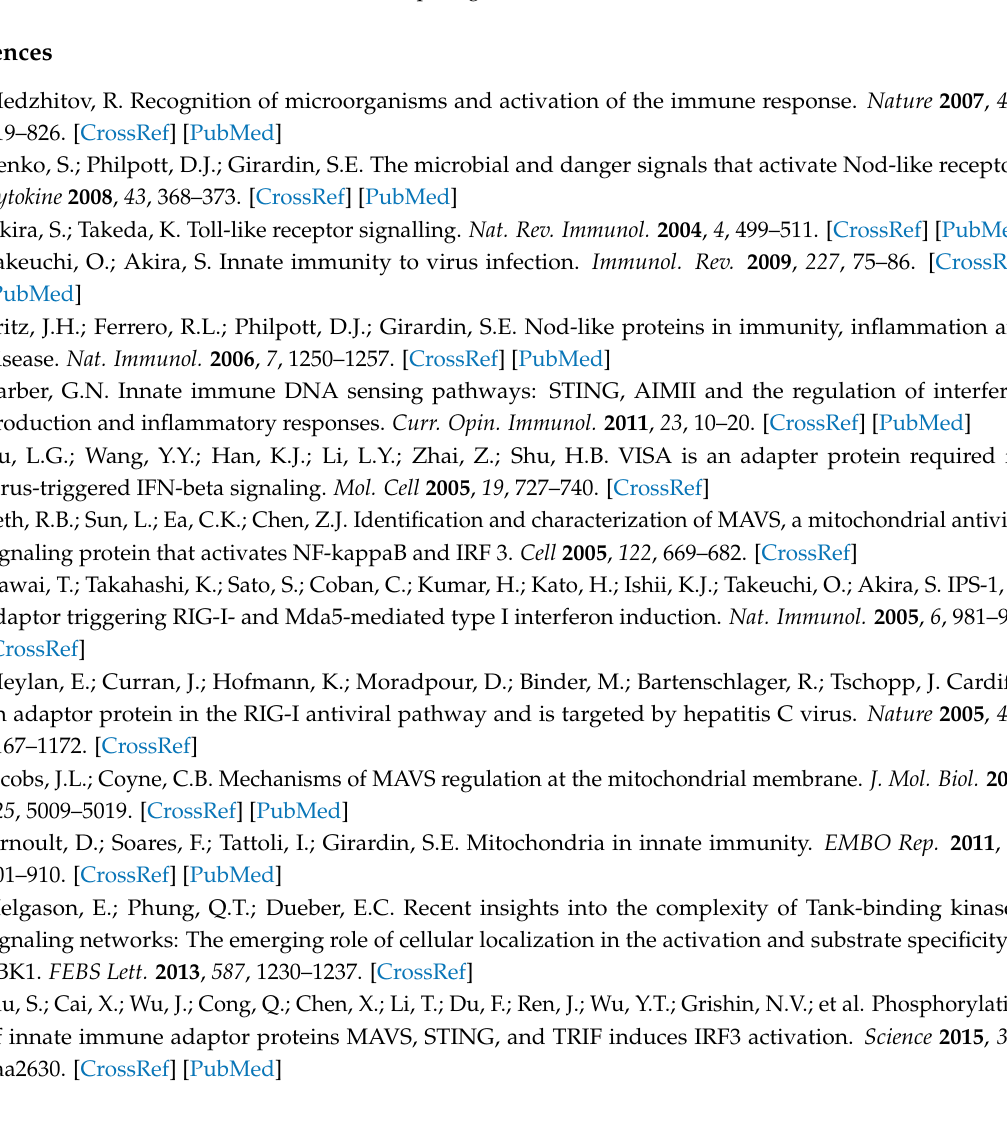
Figure S1: S1 (A) Overexpression of THOC7 promoted degradation of TBK1 in MCF7 cells. MCF7 cells were seeded into 6-well plates and transfected with Flag-THOC7 (3 µ g). After transfection for 12 h, the cells were treated with SeV or not for 10 h. (B) Knockdown of THOC7 increased the expression of TBK1 in MCF7 cells. Similar experiments were performed as (A) except transfection with RNAi control and